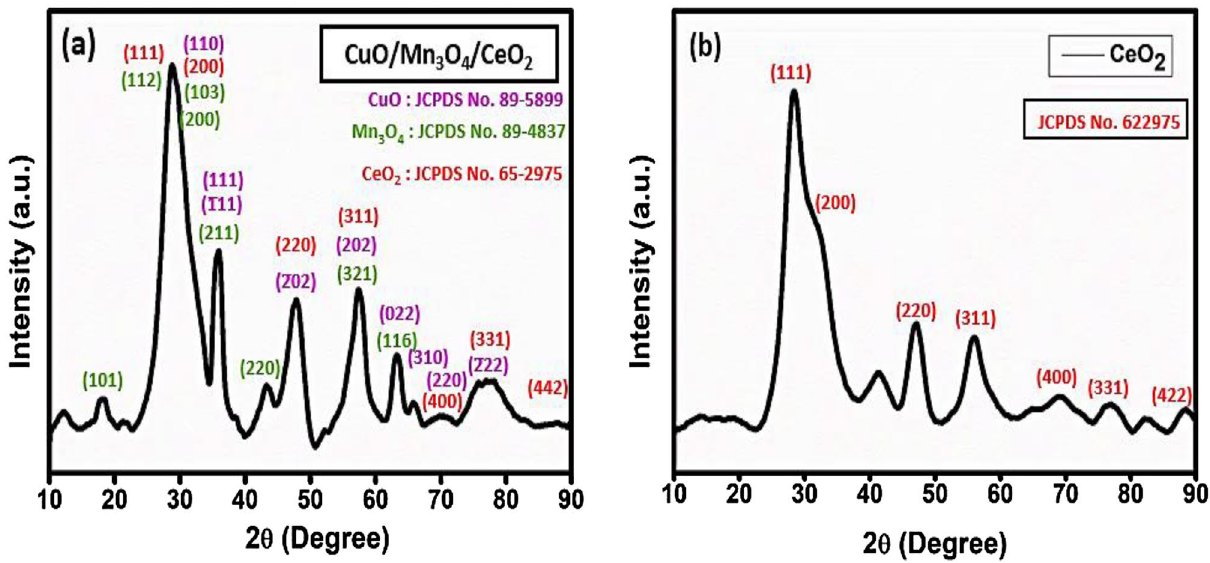
Figure 3. PXRD spectrums of ( a ) CuO/Mn 3 O 4 /CeO 2 heterostructure and ( b ) pristine CeO 2